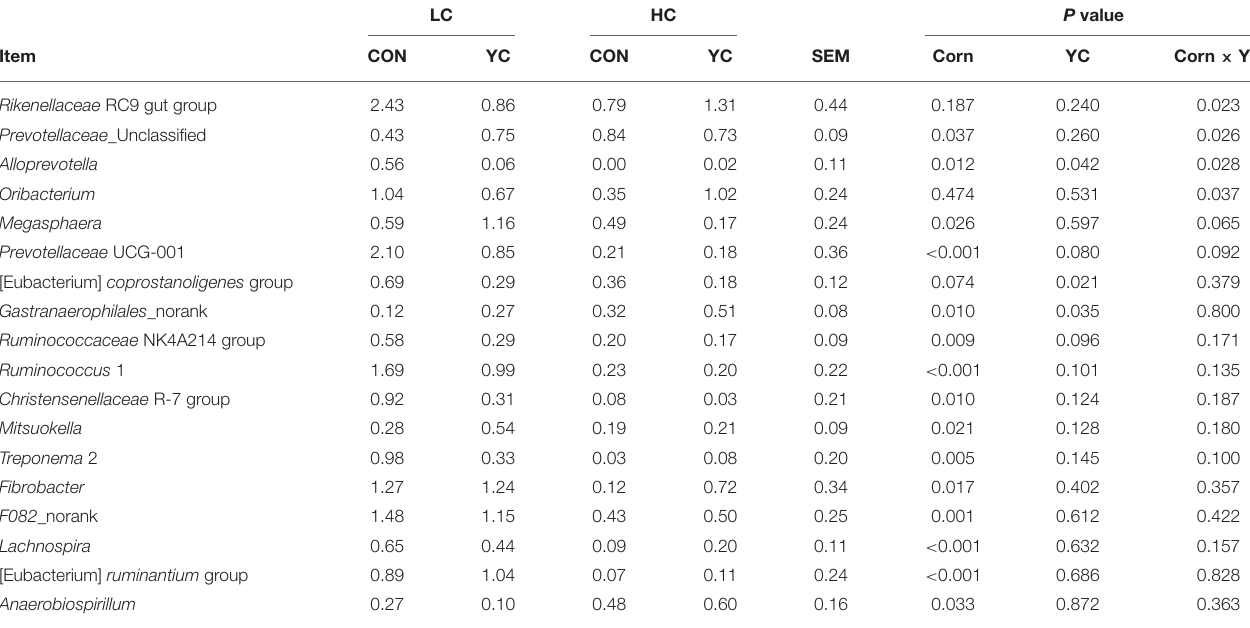
TABLE 9 | The relative abundance of ruminal bacterial genera (being higher than 0.5% of the total bacteria at least in one of the four treatments and statistically different among treatments) in fattening lambs fed experimental diets containing a low (LC) or high (HC) proportion of corn and supplemented with nil (CON) or yeast culture (YC) ( n = 12 per treatment), expressed as a percentage of the